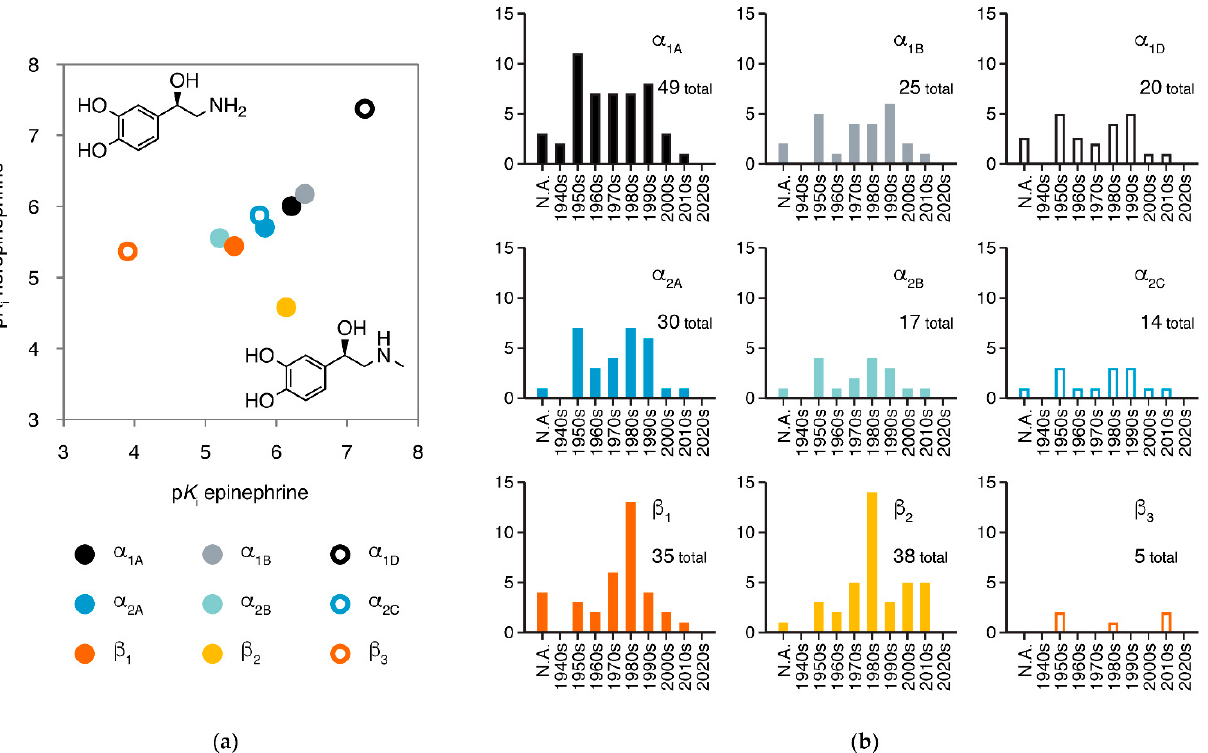
Figure 1. Adrenergic receptors as drug targets. ( a ) Binding affinities [12–14] of endogenous agonists in the nine adrenergic receptors. ( b ) Number of new drugs (approved or first marketing) for the nine adrenergic receptors in each decade. Data retrieved from Guide to PHARMACOLOGY [15] (www.guidetopharmacology.org, accessed on 25 April 2021), GPCRdb [16] (gpcrdb.org, accessed on 25 April 2021), and DrugBank [17] (go.drugbank.com, accessed on 25 April 2021).